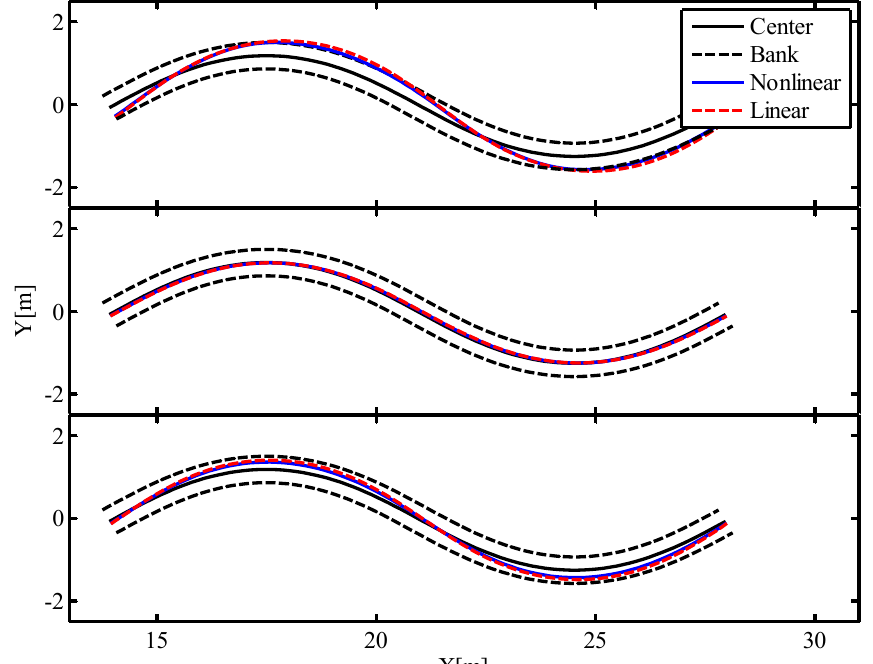
Figure 7. Comparison of the linear and nonlinear RHS terms ( top ); the difference between the discharge bisector lines and the original channel centerlines ( middle ); and the new channel centerlines after 8 h of migration ( bottom ) computed by the nonlinear and linear models in the θ 0 = 30° case.